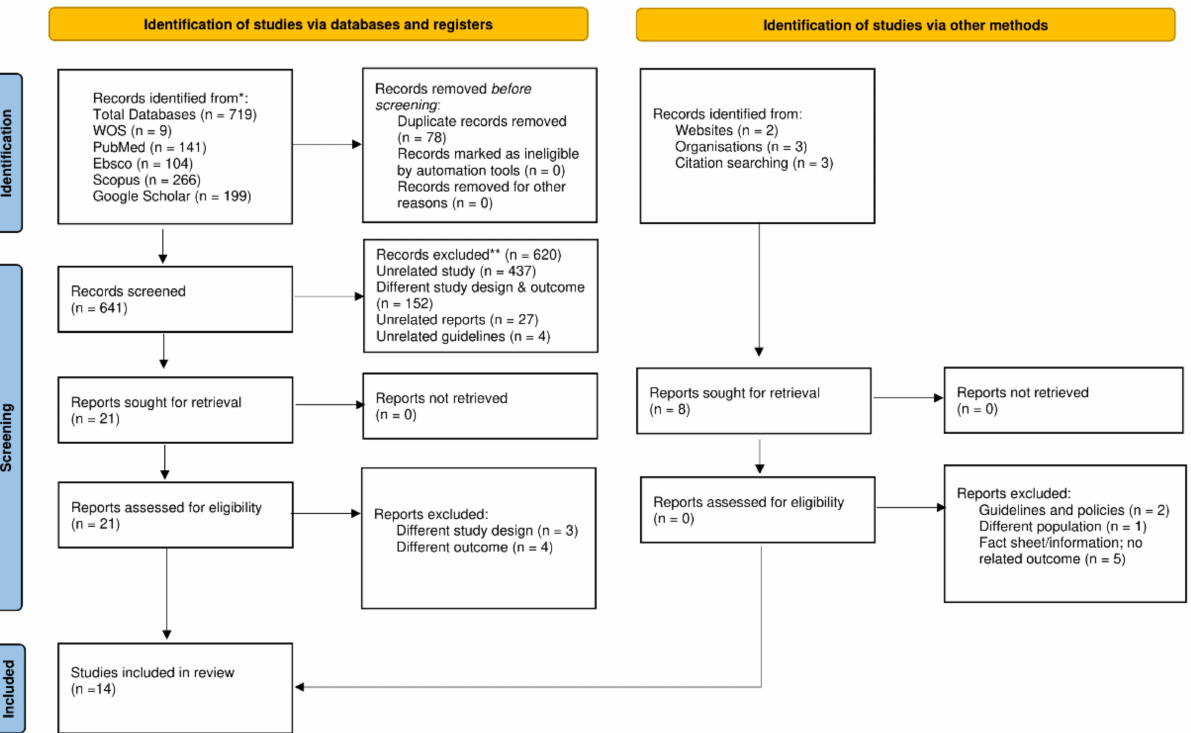
Figure 1. PRISMA 2020 flow diagram for the search process, which included searches of databases, registers, and other sources. * Consider, if feasible to do so, reporting the number of records identified from each database or register searched (rather than the total number across all